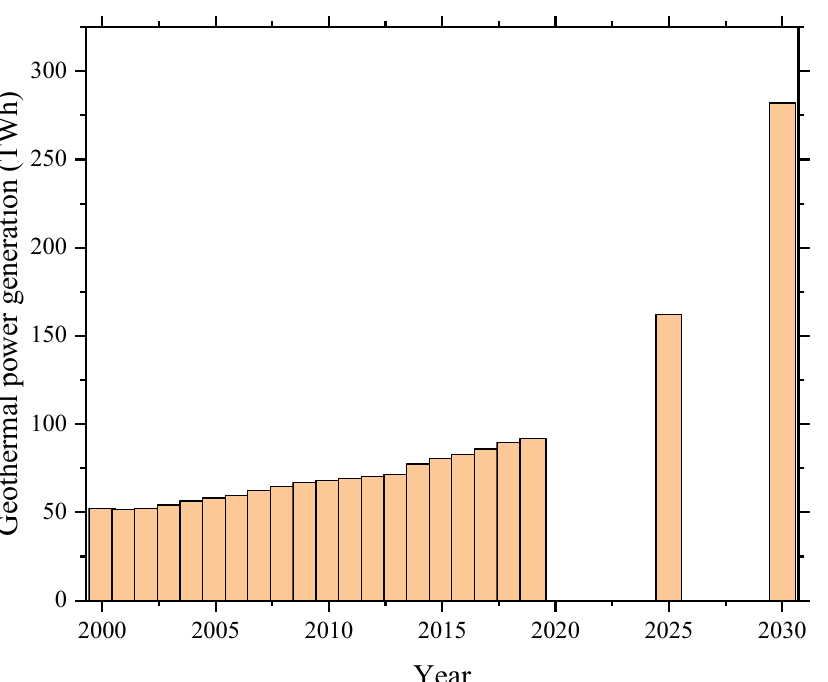
Figure 2. Trend of the installed capacity of geothermal power generation.